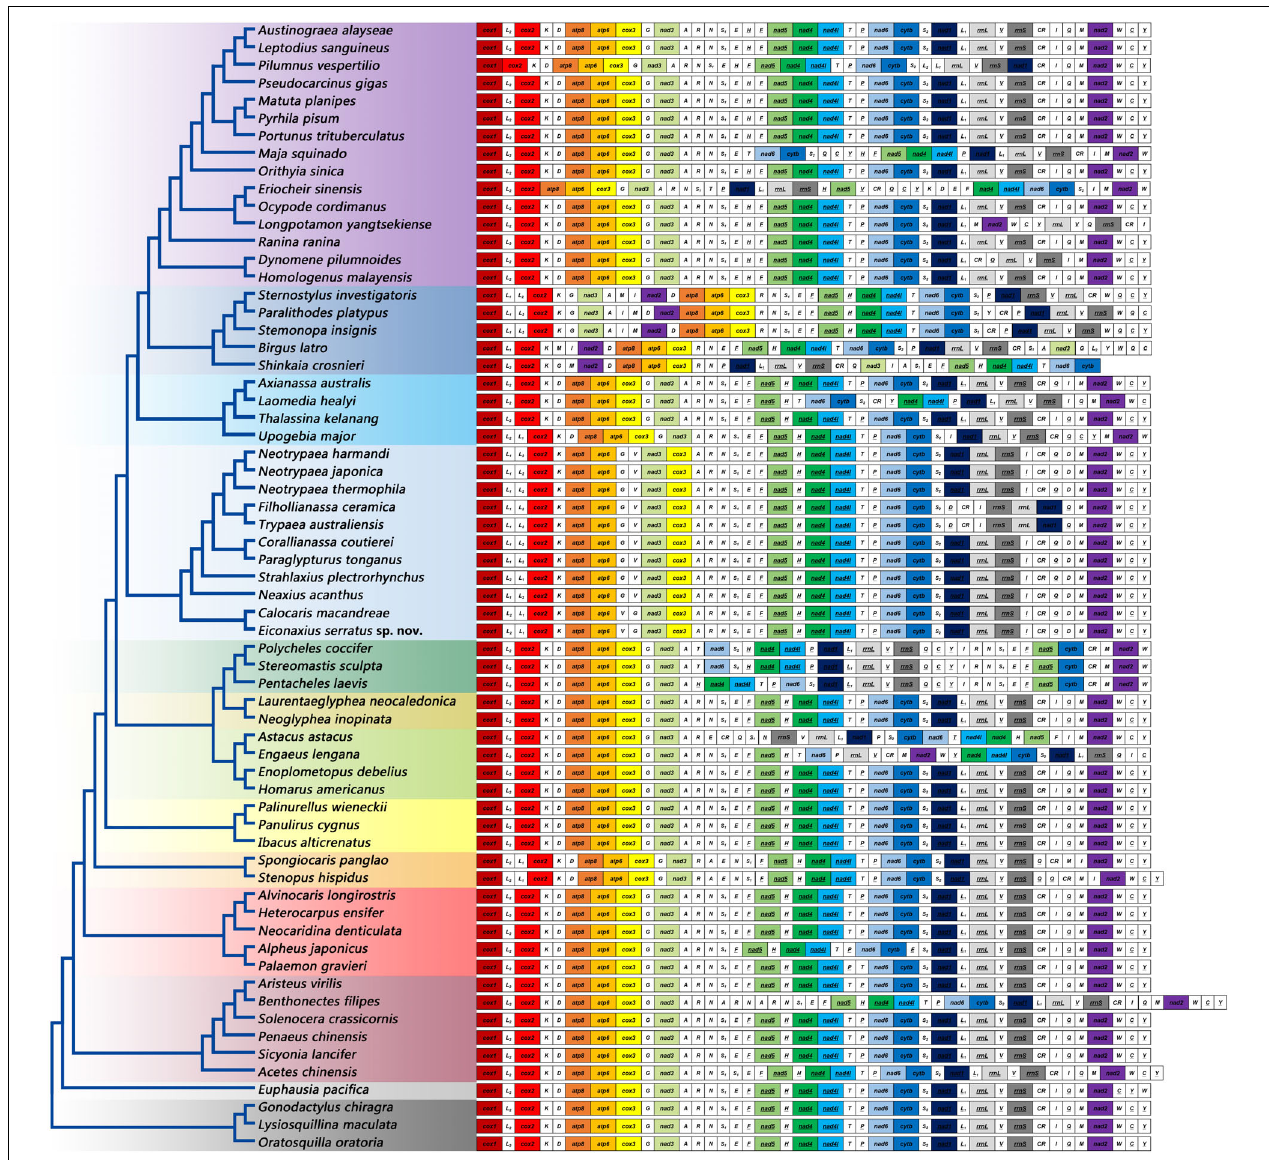
FIGURE 9 | The gene orders of mitochondrial genomes of the studied species mapped onto the ML tree. Genes encoded by the light strand are underlined. Protein-encoding and rRNA genes are color coded to emphasize patterns and gene